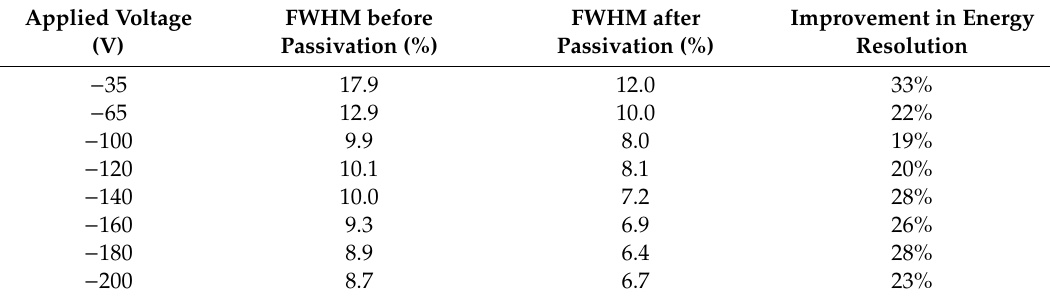
Table 1. Energy resolutions for the 59.6 keV gamma peak of Am-241 at various applied voltages. Applied